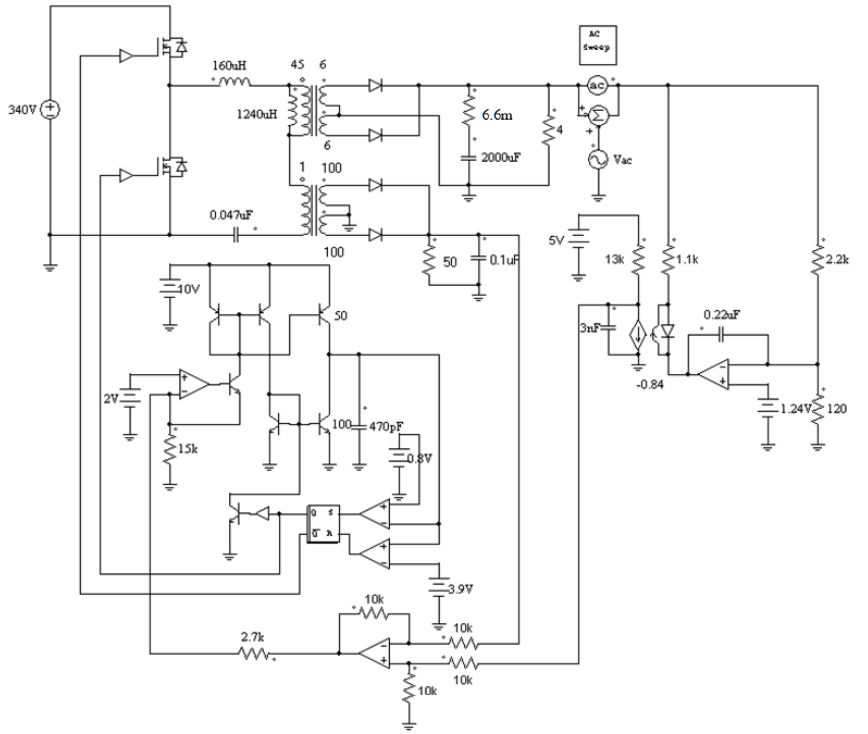
Figure A1. PSIM model for the loop gain analysis of current mode control of LLC series resonant